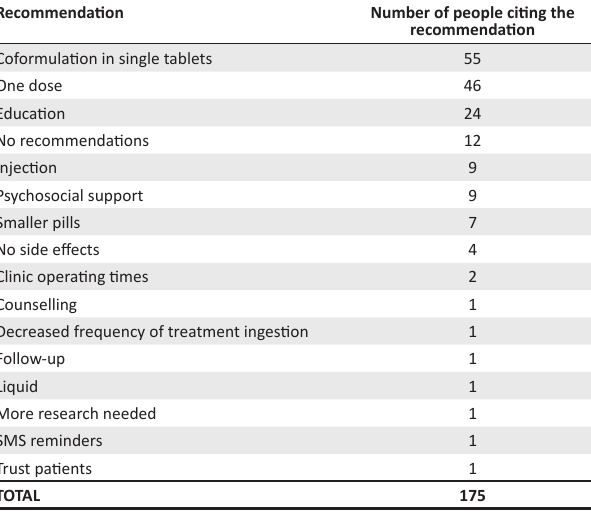
TABLE 5: Participants’ perspectives on how adherence can be improved amongst second-line patients.